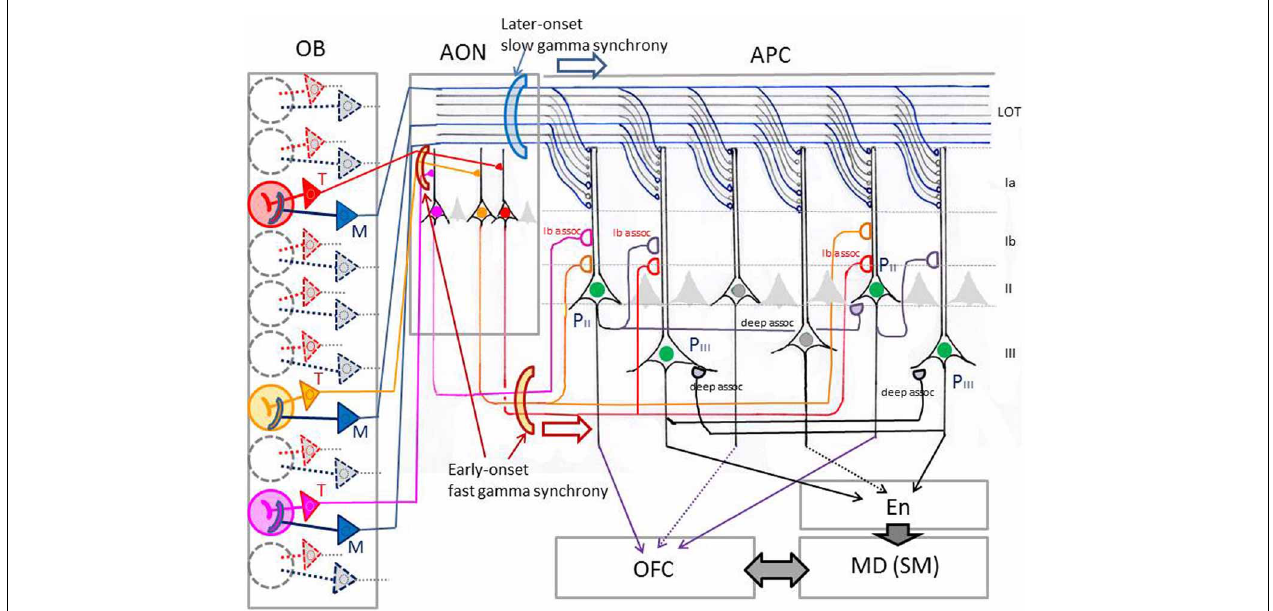
FIGURE 5 | Schematic diagram of possible functional differentiation between the tufted cell pathway and mitral cell pathway in odor information processing in the neuronal circuits of the piriform cortex. In this model, red, yellow, and pink glomeruli are assumed to be activated simultaneously by an odor inhalation. Activated tufted cells (T, shown by red, orange, or pink) send the odor information with early-onset fast gamma synchrony to specific target pyramidal cells in the AON, which in turn send the information presumably with fast gamma synchrony to specific-target pyramidal cells in the APC. Activated mitral cells (M, shown by blue) provide dispersedly-projecting feed-forward binding circuits transmitting the spike synchronization timing with later-onset slow gamma synchrony to whole pyramidal cells in the APC. Pyramidal cells in layer II